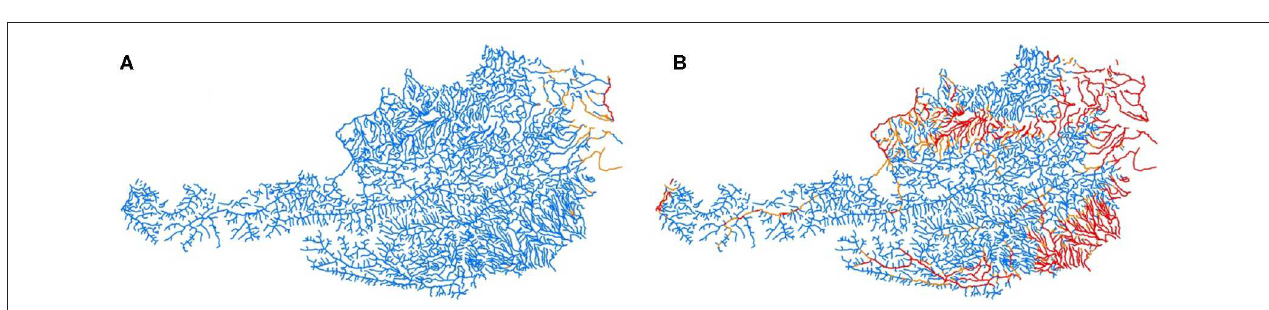
FIGURE 5 | TR-PKD in Austrian rivers for (A) in the past (1971–2000), (B) under current conditions (2000–2011), as well as for the future scenarios (C) near future RCP4.5, (D) far future RCP4.5, (E) near future RCP8.5, and (F) far future RCP8.5. Color codes: No outbreak, blue; possible outbreak, orange; low mortality, red; and high mortality,